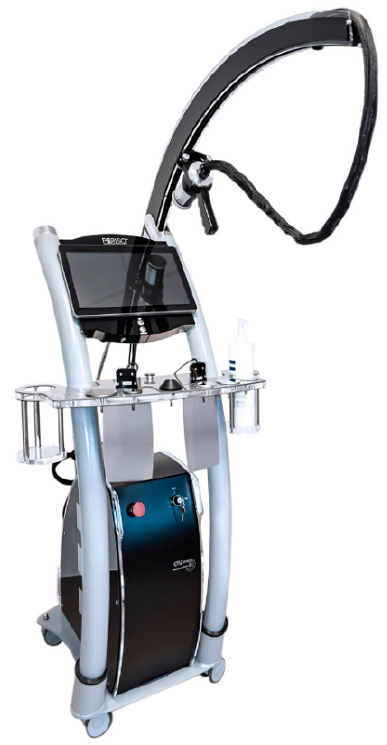
Figure 1. PEMF Figure 1. PEMF generator.